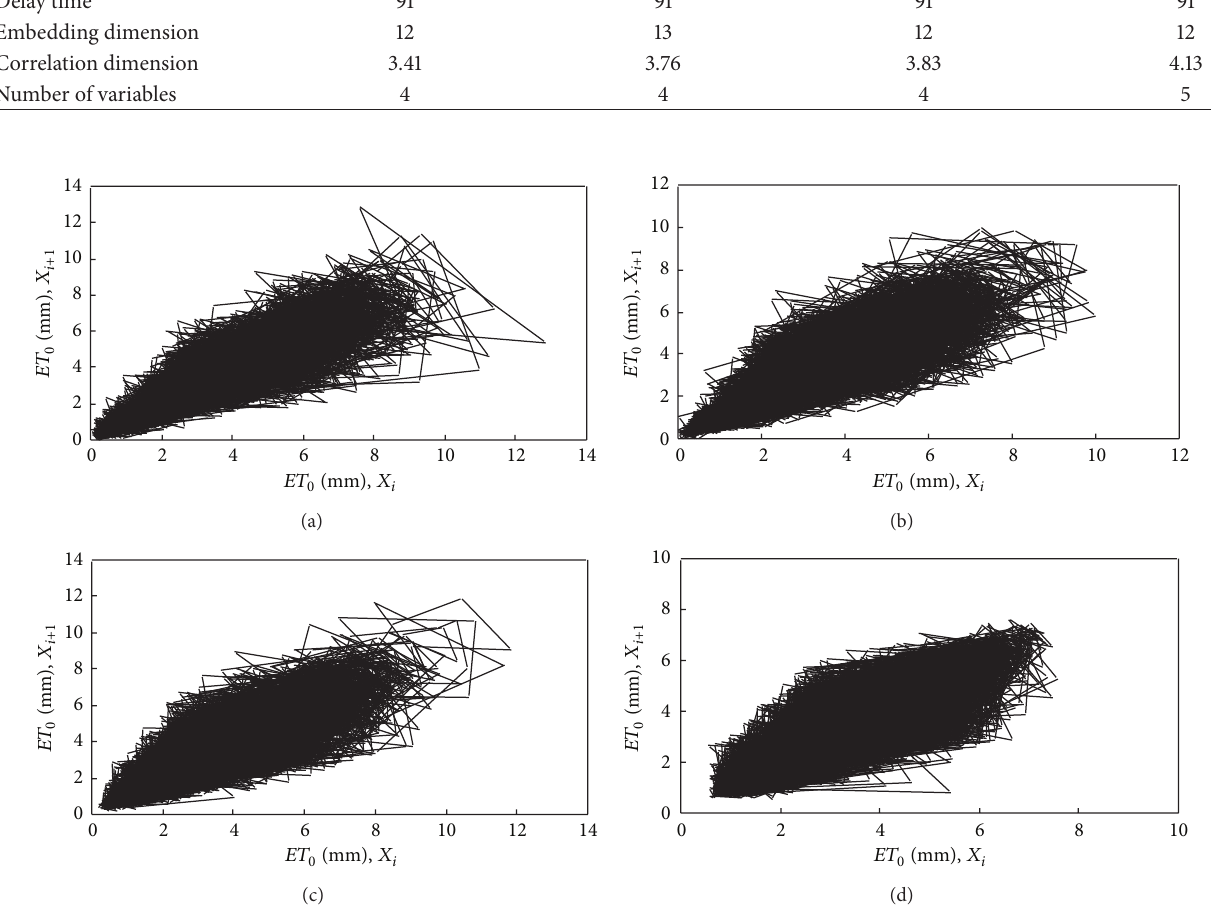
Figure 3: Two-dimensional phase portrait of the daily reference evapotranspiration time series reconstructed for 𝜏 = 1 : (a) Baotou station; (b) Zhangbei station; (c) Kaifeng station; (d) Shaoguan